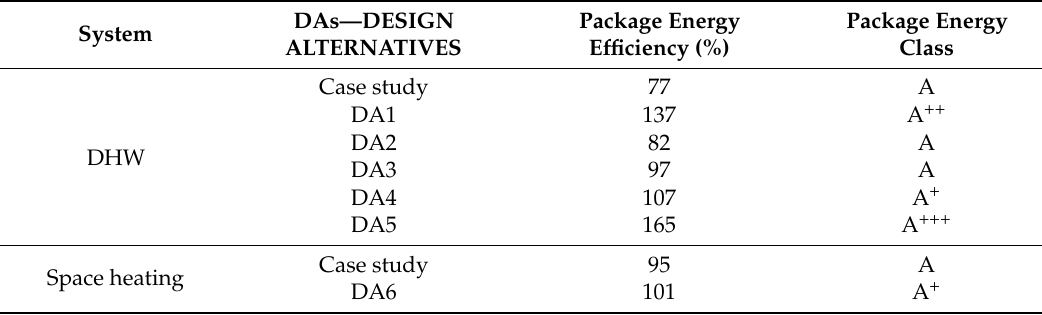
Table 7. Summary of the results for the package-improving potential of upgrading the products. DAs—DESIGN ALTERNATIVES